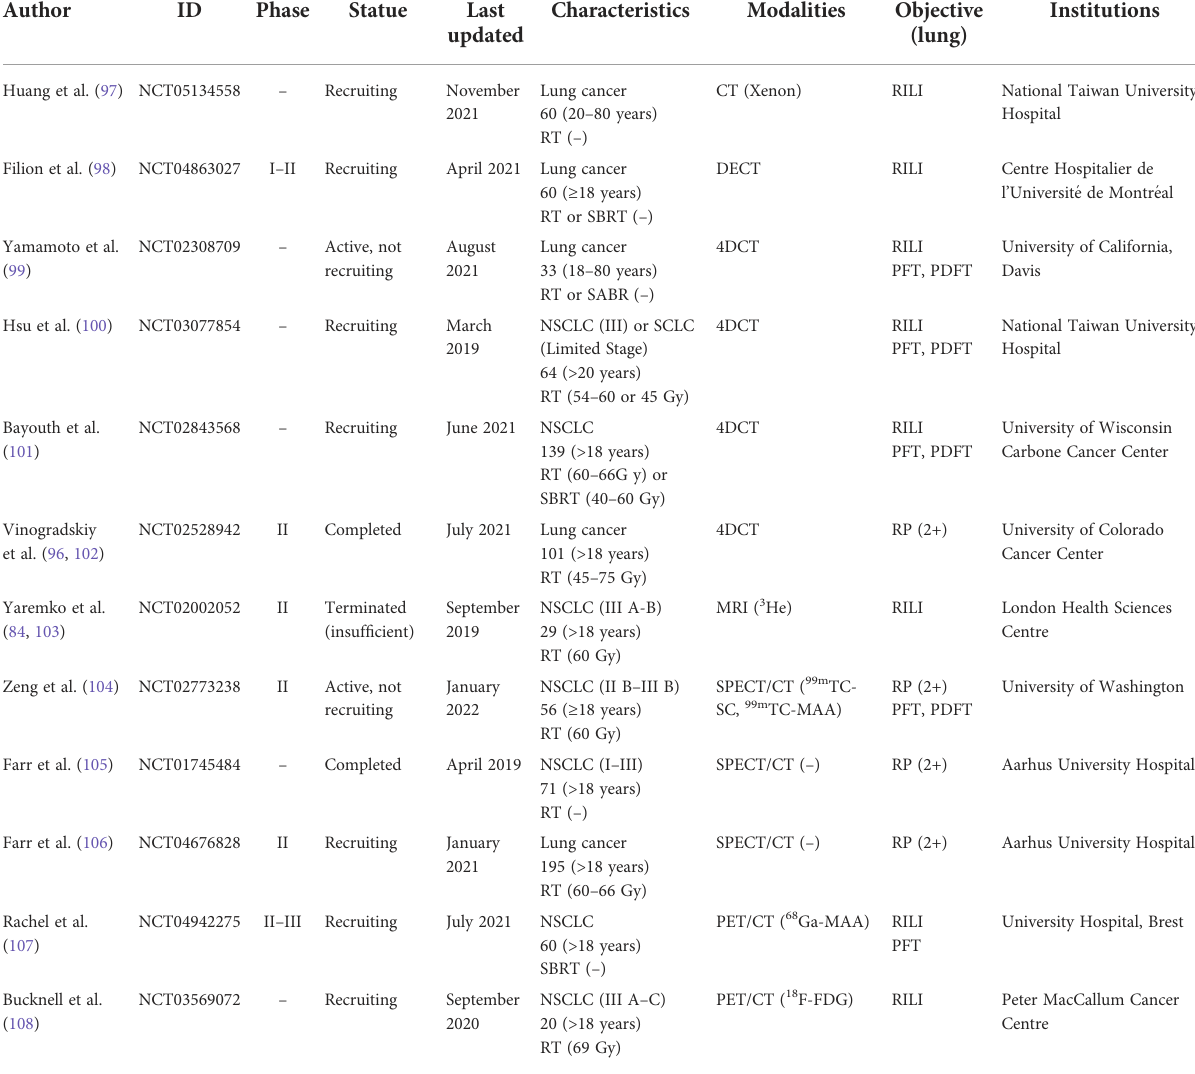
TABLE 1 Registered clinical trials of functional lung sparing planning-guided radiotherapy (from